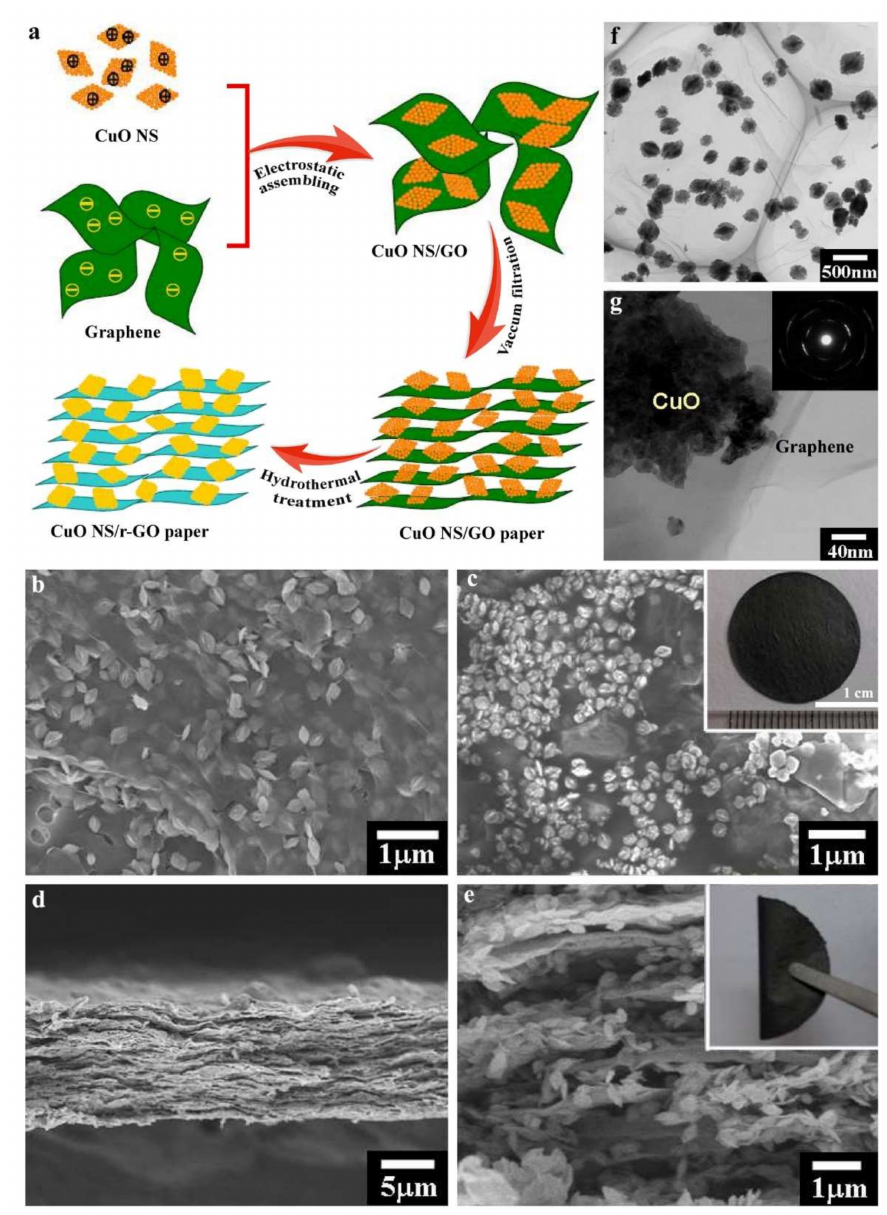
Figure 15. ( a ) Schematic representation of the synthesis of flexible free-standing CuO nanosheets (NSs) with graphene oxide (GO)/reduced graphene oxide (r-GO) hybrid lamellar paper via simple vacuum filtration method followed by hydrothermal reduction (CuO NSs/GO and CuO NSs/r-GO paper); Morphological analysis of the sample, top-view SEM images ( b ) CuO NSs/GO and ( c ) CuO NSs/r-GO paper, the inset in c is a digital photograph of CuO NSs/rGO paper with a diameter of ca. 19 mm; Cross-section SEM images of ( d , e ) CuO NSs/r-GO paper, the inset in e is a digital photograph shows good flexibility (the inset in e), ( f , g ) TEM images of the CuO NSs/r-GO paper, inset of ( g ) is electron diffraction pattern. Adapted and reproduced with permission from Ref. [73]. Copyright 2013 American Chemical